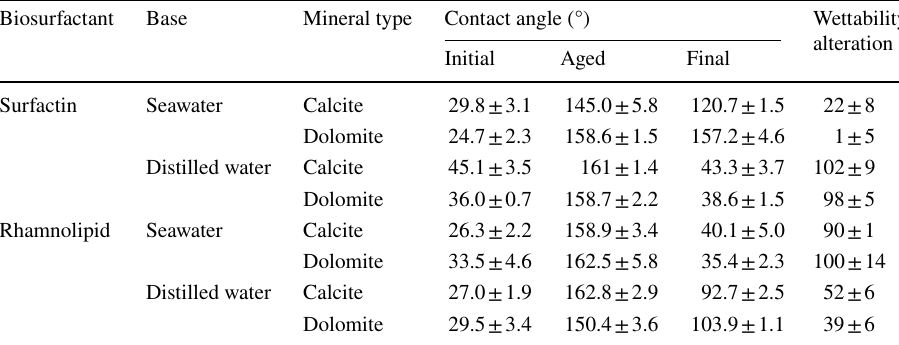
measurement results for two different biosurfactants: surfactin and rhamnolipid; surfactin can change wettability of calcite and dolomite surfaces only in distilled water, while rhamnolipid is effective also in